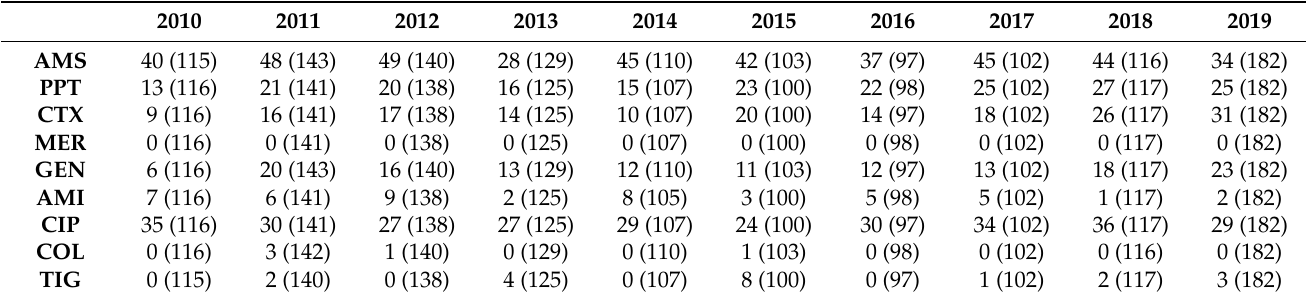
Table 8. Resistance of Escherichia coli to antibiotics at the Department of Anesthesiology and Intensive Care Medicine in 2010–2019.